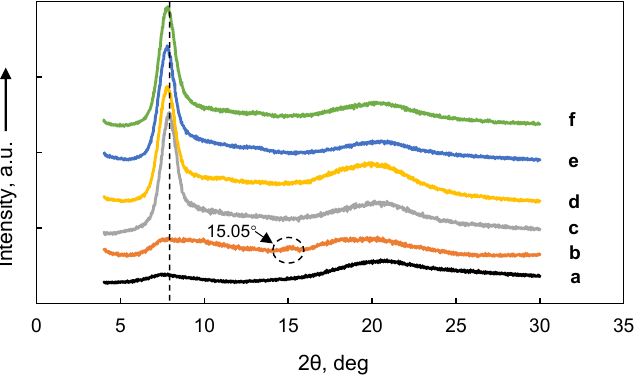
Figure 5. X-ray diffractograms of MC films and MC-SNC nanocomposite films: (a) M20; (b) M20-15% SNC; (c) A4C; (d) A4C-15% SNC; (e) A4M; (f) A4M-15% SNC.